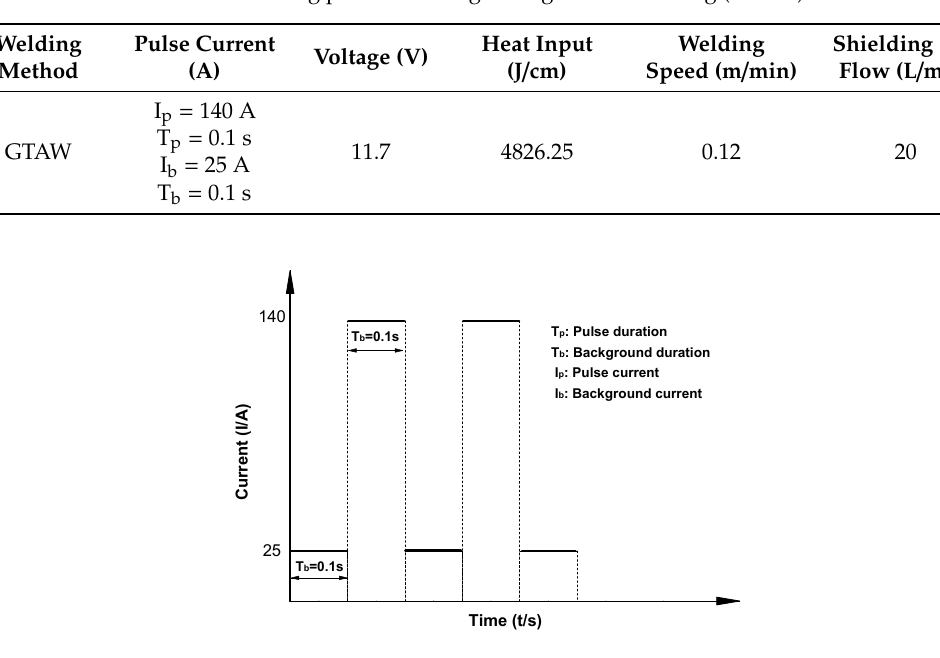
Figure 1. Main parameters of the pulse signal for GTAW.